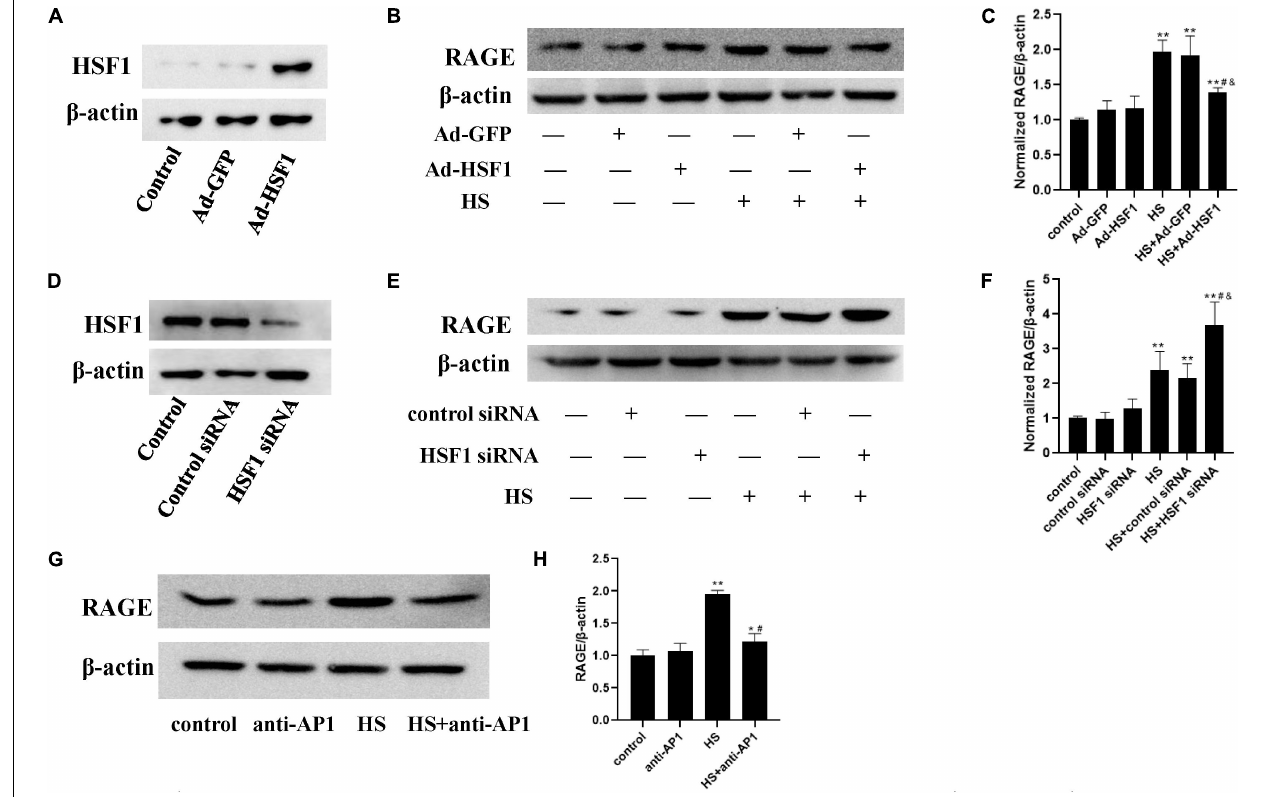
FIGURE 7 | Involvement of HSF1 and c-Jun in heat-induced RAGE protein expression changes. (A,D) Evaluation of transfection efficiency of HSF1 adenovirus or siRNA. Cells were infected with HSF1 adenovirus or siRNA for 48 h, and total protein was extracted and subjected to western blot to evaluate the expression of HSF1. HUVECs were pre-transfected with HSF1 adenovirus to overexpress or HSF1 siRNA to downregulate HSF1, or incubated with AP-1 inhibitor to inhibit the function of c-Jun, followed by heat stress at 42 ◦ C for 2 h, and the RAGE protein expression was detected 2 h after heat stress by western blot. (B,C) Overexpression of HSF1 using adenovirus vector suppressed the expression of RAGE protein after heat stress; (E,F) Knockdown of HSF1 using siRNA significantly increased the expression of RAGE protein after heat stress. (G,H) AP-1 inhibitor suppressed heat-evoked elevation of RAGE protein expression (* P < 0.05, ** P < 0.01 vs control group, # P < 0.05 vs HS, & P < 0.05 vs HS+Ad-GFP/control siRNA